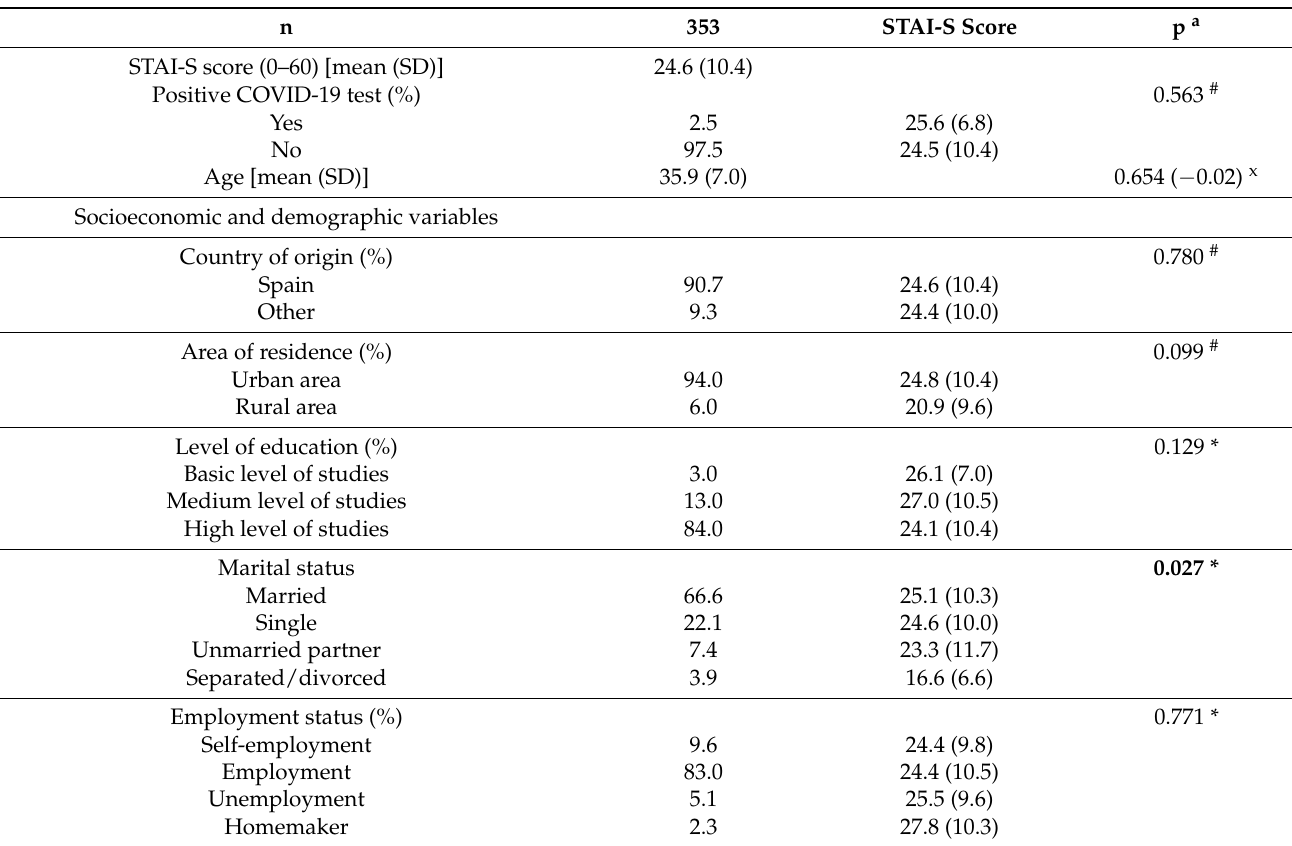
Table 1. Characteristics of the participants examined and bivariate analyses between STAI-S score and socioeconomic and demographic factors, pregnancy-related factors, health-related concerns and health information-related factors. n 353 STAI-S Score p a STAI-S score (0–60) [mean (SD)] 24.6